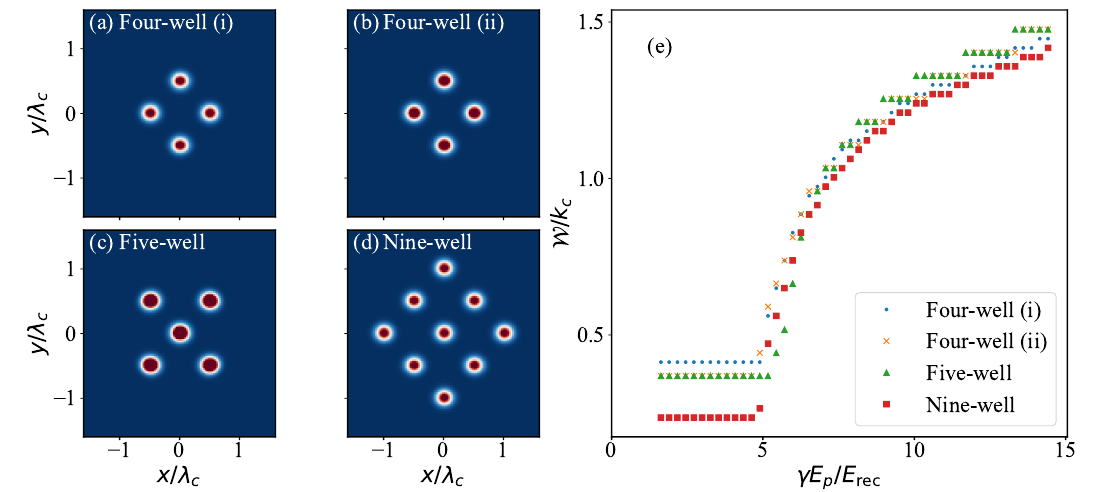
Figure 8: (a-d) Exemplary real-space density distributions of (a) the four-well system described by Eq. (12b) in Sec. 3.3, (b) an alternative realization of the four-well system, (c) a five-well system, and (d) a nine-well system. (e) The width W of the central peak in the momentum space as a function of the pump strength E four